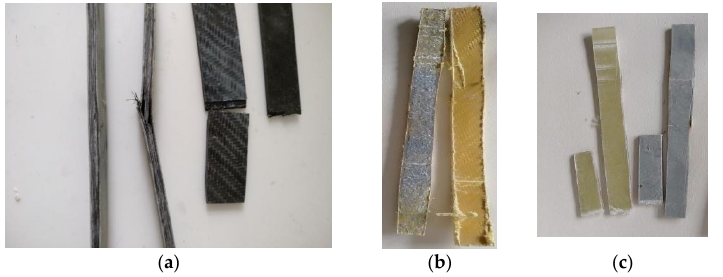
Figure 13. Specimens tested in bending and shear strength: ( a ) carbon fiber specimens; ( b ) Kevlar specimens; ( c ) glass fiber